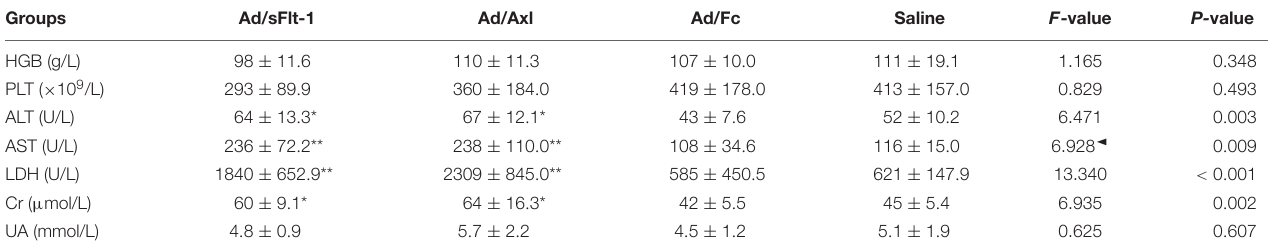
TABLE 2 | Blood HGB, PLT counts and biochemical index values ( n = 6, X ± SD). Groups